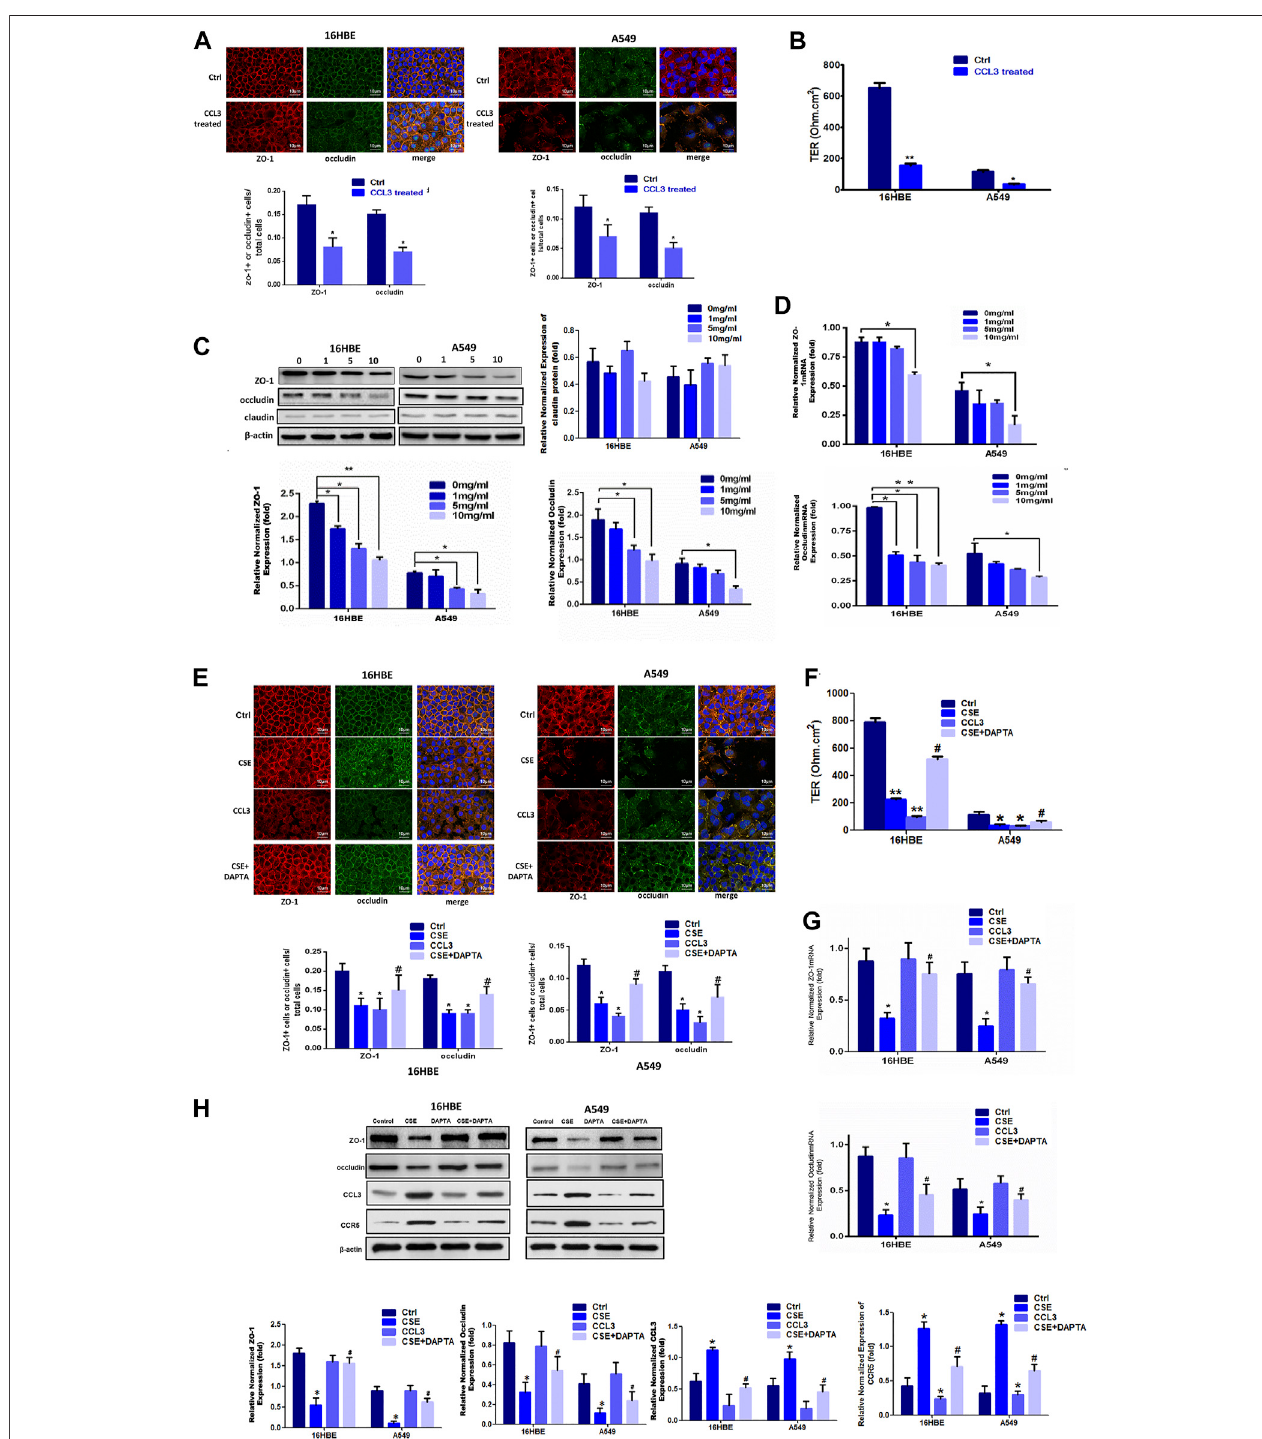
FIGURE2| CCL3promotesepithelialtightjunctioninjurybybindingwithCCR5 (A) TightjunctionproteinsZO-1(red),occludin(green),andmerged(blue+orange) werestainedin16HBEcells(leftpanel)andA549cells(rightpanel)byimmuno fl uorescence.Presentedasmeans ± standarderror. n (cid:2) 3,* p < 0.05,vs.thecontrolgroup. Data are representative of three independent experiments. Scale bar (cid:2) 10 µm (B) Transepithelial electrical resistance (TER) after CCL3 treatment (10 mg/ml), as a cell functiontest 7 days after plating theairway epithelialcells oncoated permeable fi lters.Presented asmeans ± standard error. n (cid:2) 3,* p < 0.05, vs. thecontrol group (C) Western blot analysis to detect protein expression of ZO-1, claudin and occludin in 16HBE cells and A549 cells using different concentrations of CCL3. n (cid:2) 3, * p < 0.05, vs. the control group, ** p < 0.01, vs. the control group (CCL3: 0 ng/ml). The expression levels were normalized to the expression of β -actin (left panel). n (cid:2) 3